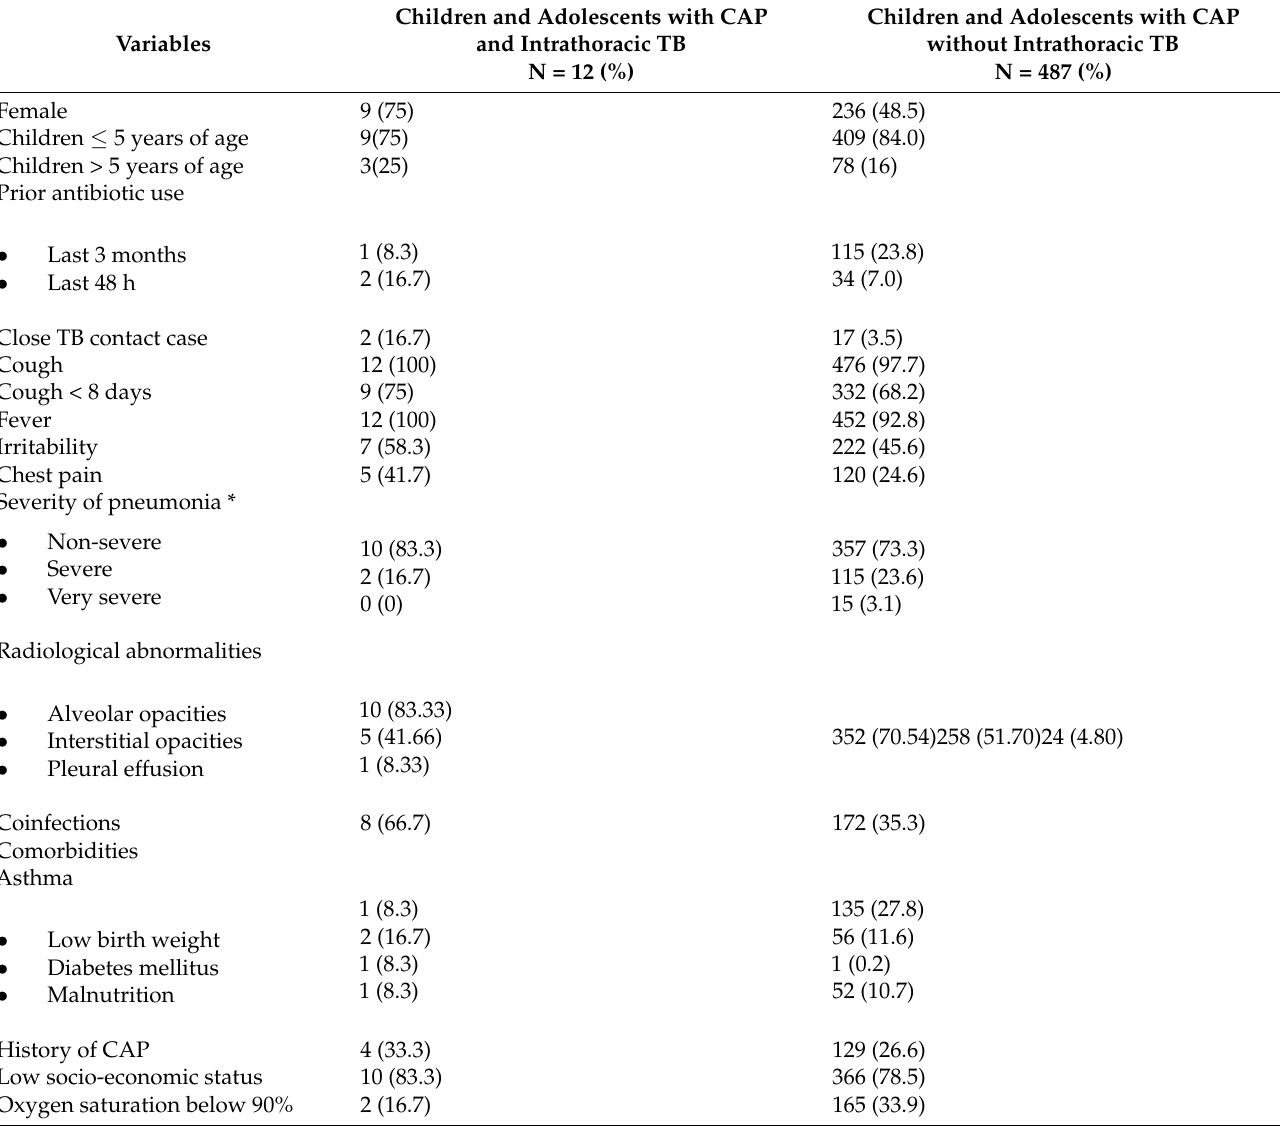
Table 1. Baseline characteristics of children and adolescents with intrathoracic TB and community- acquired